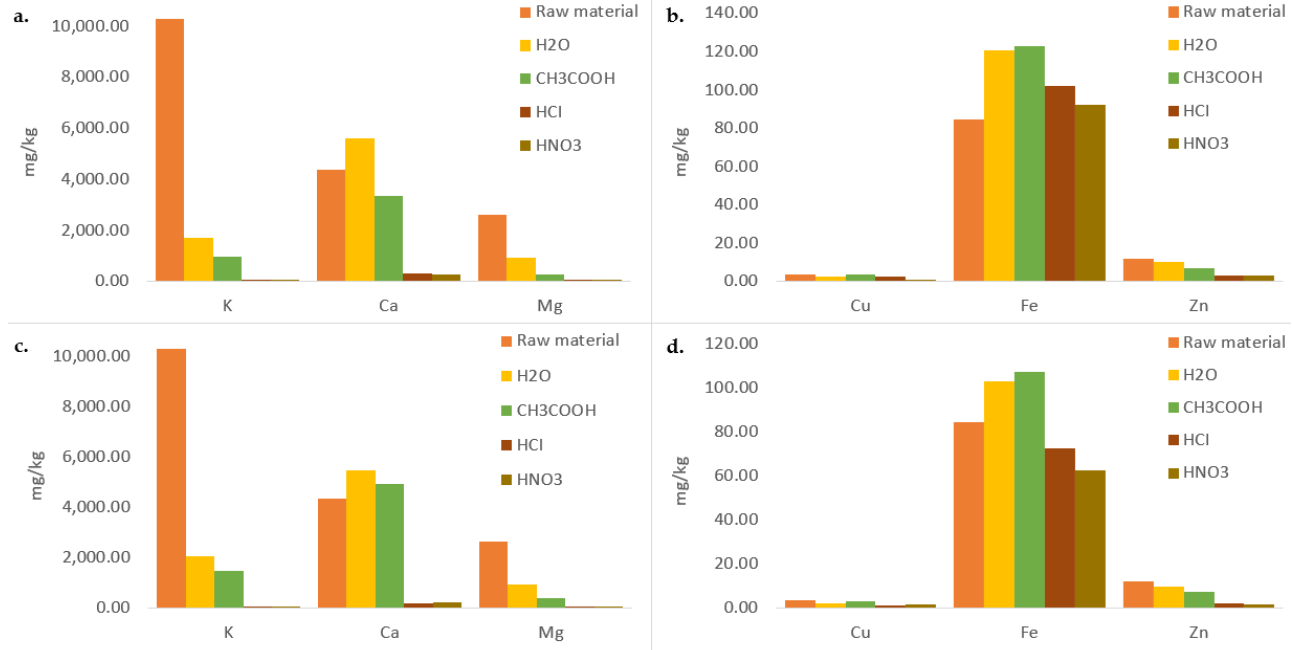
Figure 1. Atomic spectrometry analysis of: ( a ) macro elements in untreated and treated corn I within 30 min ( b ) micro elements in untreated and treated corn I within 30 min ( c ) macro elements in untreated and treated corn I within 240 min ( d ) micro elements in untreated and treated corn I within 240 min.